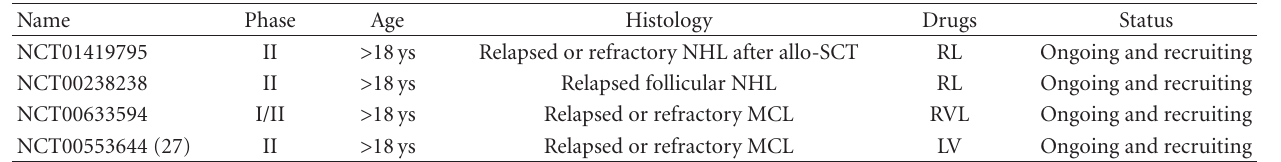
Table 4: Ongoing lenalidomide-based regime